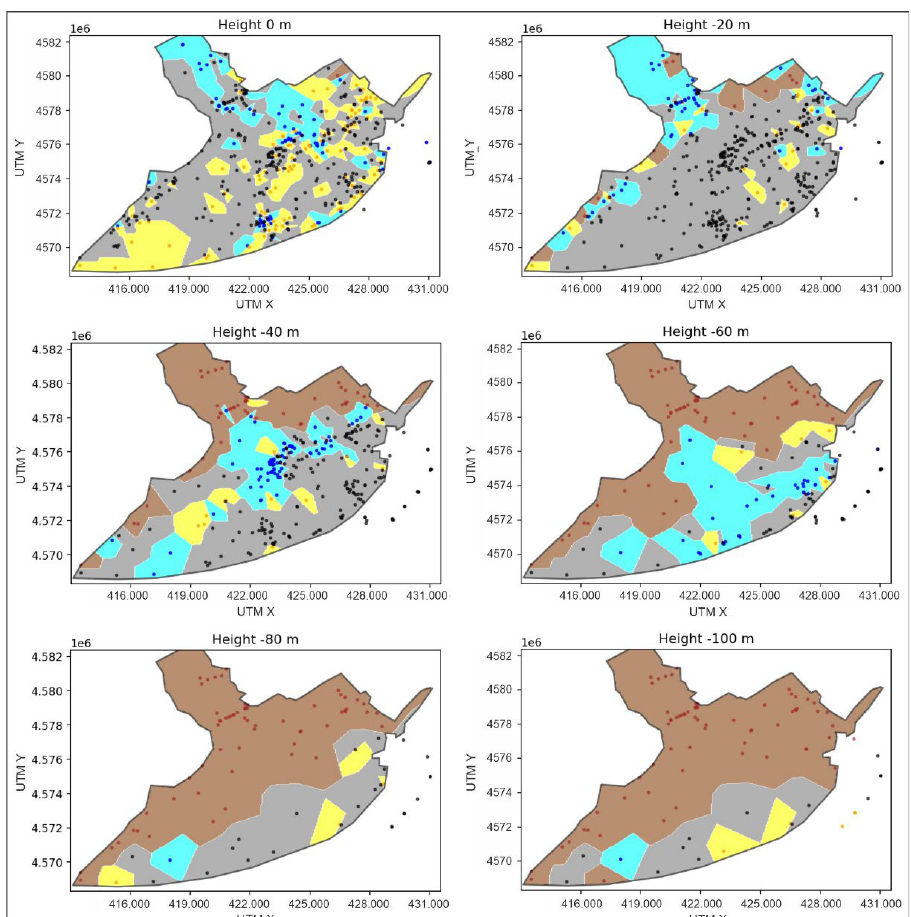
Figure 4. Some horizontal sections of the granulometry classes created with the KNN algorithm at 0, 20, 40, 60, 80, and 100 m below sea level in the onshore Quaternary LRD. The granulometry data were clustered into the gravel (>5 mm, cyan), coarse sand (1–5 mm, yellow), clay-silt (<1 mm, gray), and basement (brown) classes. The points display the boreholes with granulometry data at the modeled depth.